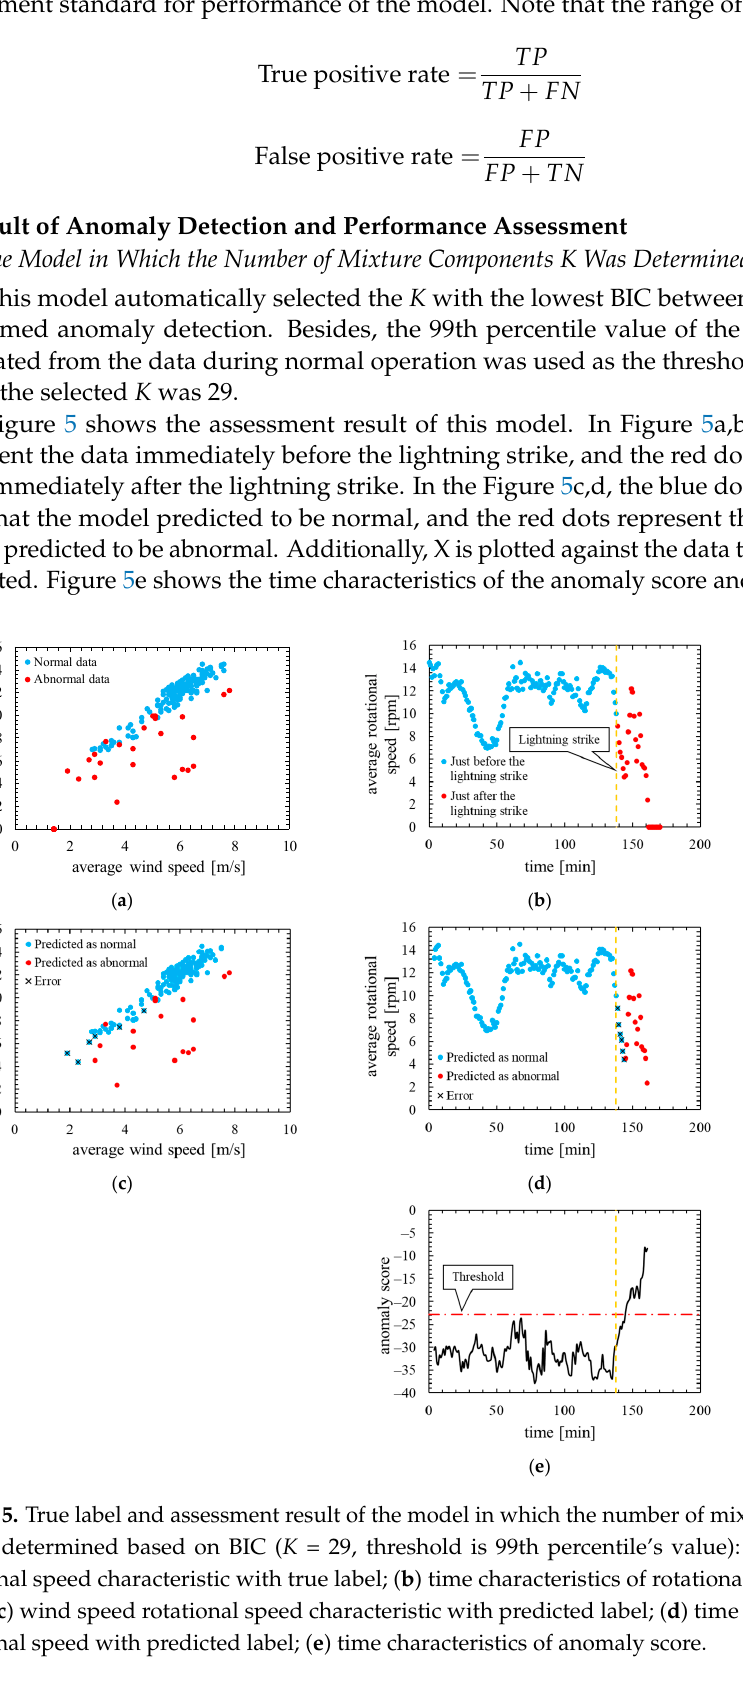
Figure 6. ROC curve of the model in which the number of mixture components K was determined based on BIC ( K = 29, the threshold is the 99th percentile’s value).